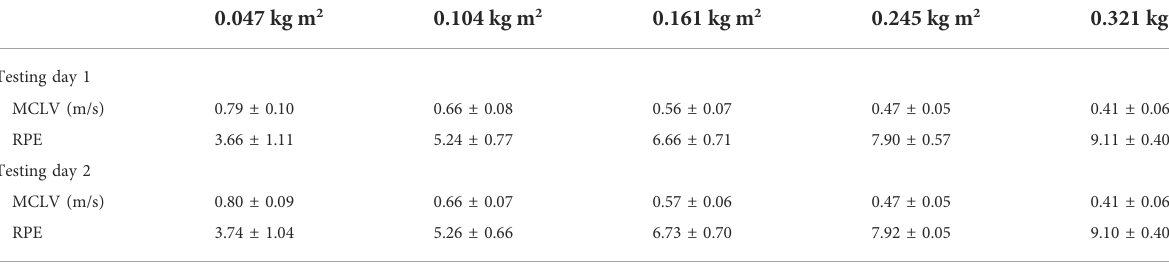
TABLE 1 Mean ± SD of MCLV and RPE for each load and testing day.